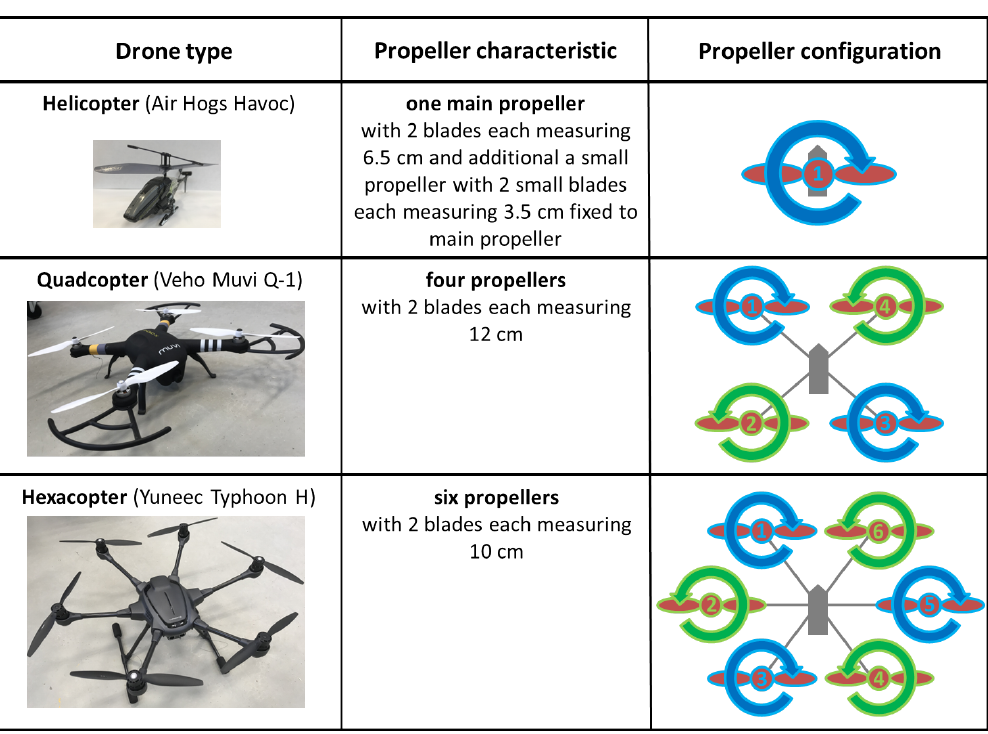
Figure 1. Drone propeller characteristics and